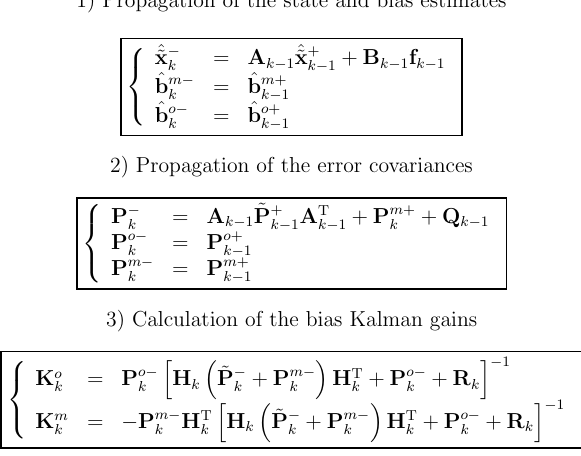
− ˆ b m − is defined k k